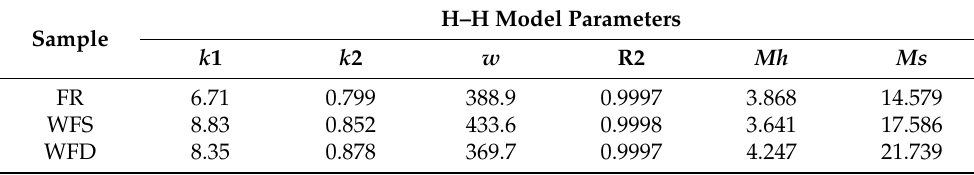
Table 1. Coefficients of the H–H model for WFD, WFS, and recent wood.